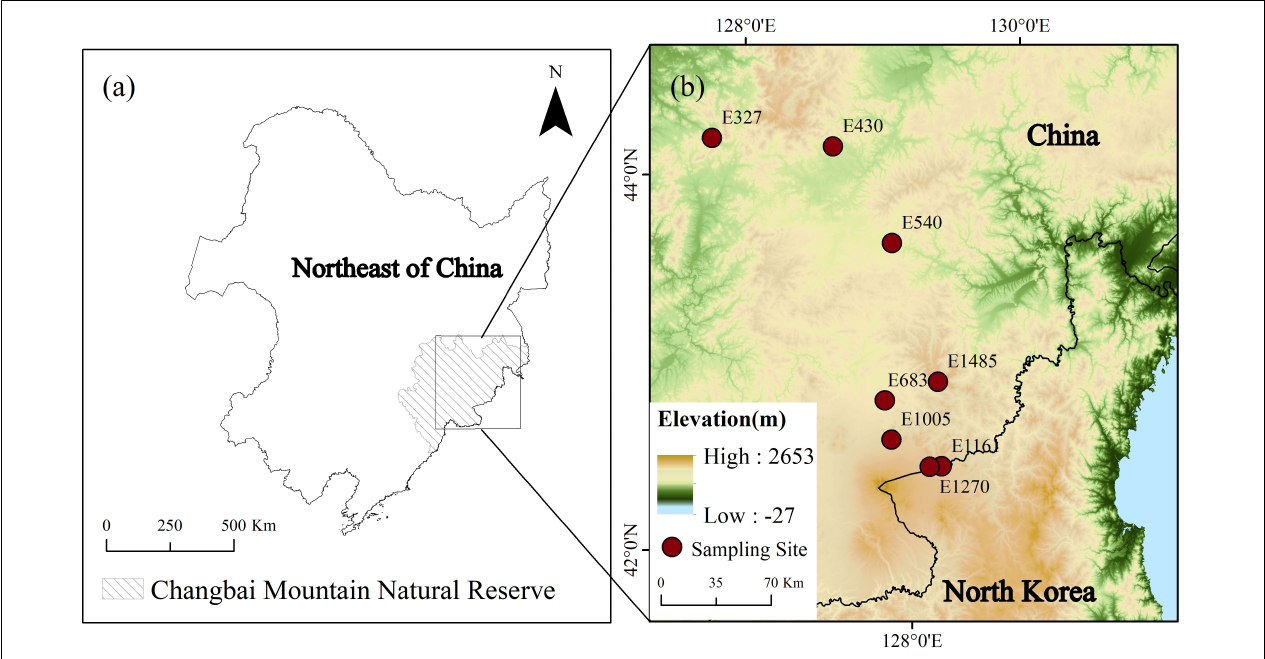
FIGURE 1 | Locations of the sampling sites along the altitude gradient in peatlands of the Changbai Mountain, China. TABLE 1 | Site information and general climate and soil characteristics in the sedge-dominated peatlands of the Changbai Mountains, China. MAT MAP TOC SWC